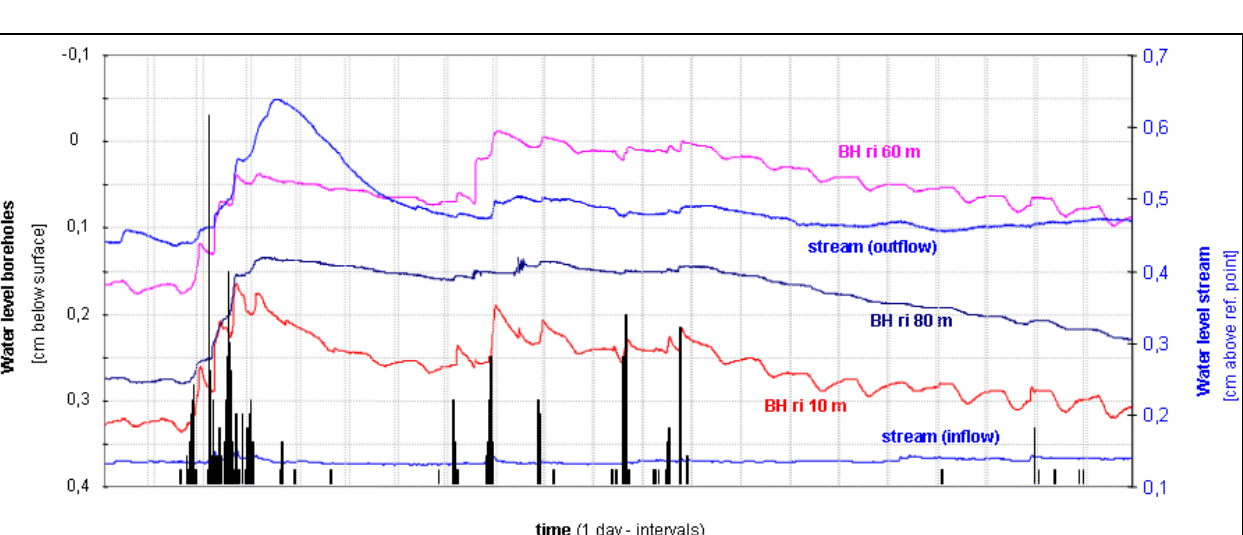
Figure 27. Water level changes in boreholes at portion 7 as well as at the in- and outflow of the GMB stream in response to rainfall (September